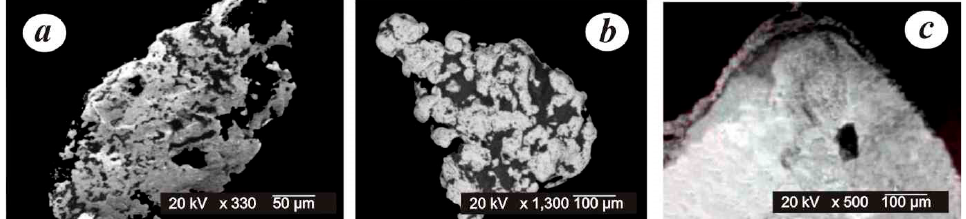
Figure 5. Internal structures of placer gold from the hypergenesis zone: ( a ) porous, mercury removal; ( b ) kidney-shaped, removal of tellurides; ( c ) loose, high-grade shell on mono-grain .